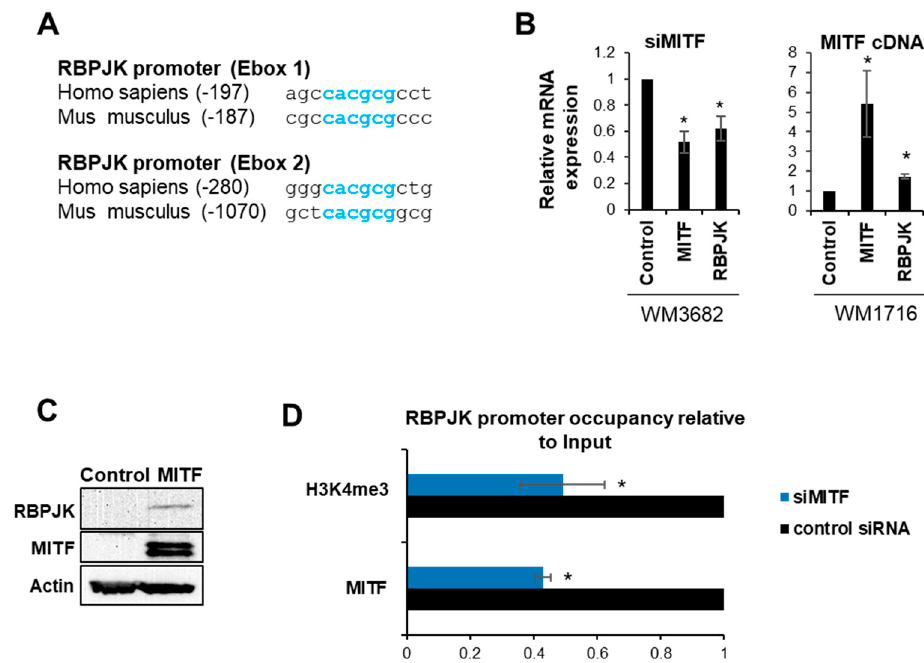
Figure 2. RBPJK increases MITF expression. ( A ) Two conserved MITF DNA binding sites (E-boxes, represent in blue) in the RBPJK promoter sequence. ( B ) Melanoma cells with high levels of MITF (WM3682, left panel) and low levels of MITF (WM1716, right panel) were treated with siMITF or MITF cDNA, respectively, followed by RBPJK expression level analysis. As controls, cells were treated with siControl or empty cDNA, respectively. Expression levels were normalized to Glyceraldehyde 3-phosphate dehydrogenase (GAPDH). Error bars represent SEM, * p < 0.05 ( n = 3). ( C ) Western blot analysis of RBPJK and MITF protein levels in cells transfected with MITF cDNA or an empty plasmid. Actin was used as loading control. ( D ) Chromatin immunoprecipitation (ChIP) was performed on extracts from WM3682 cells transfected with siMITF or siControl. Protein:chromatin-crosslinked complexes were precipitated with the indicated antibodies. PCR primers spanning the region encoding the RBPJK promoter were used. The data show promoter occupancy relative to input. Error bars represent SEM, * p < 0.05 ( n = 3).